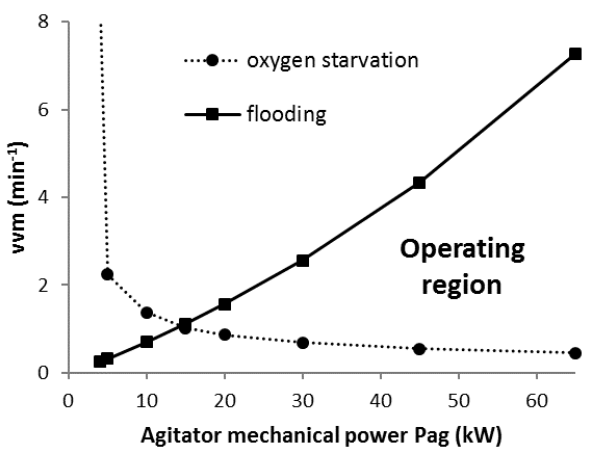
Figure 2. Scenario K: Limiting constraints on vvm and agitator mechanical power: oxygen starvation and impeller flooding.